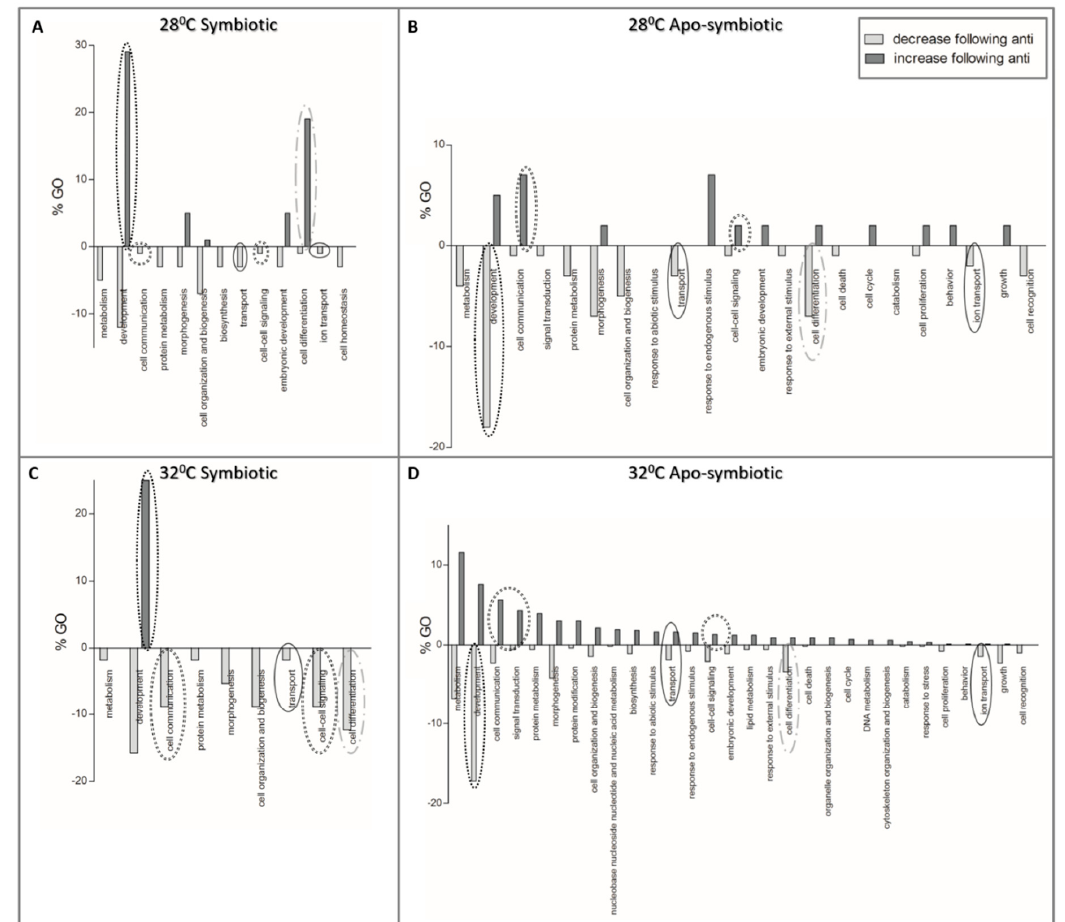
Figure 6. The e ff ect of antibiotic exposure on coral host gene expression. Enriched Gene Ontologies (GOs) of di ff erentially expressed genes which their fold change was either lower (light grey) or higher (dark grey) following the antibiotic exposure. GO slim terms, generated by the web-based tool CateGOrizer [50], are presented as a percentage of the total GOs. ( A ) symbiotic E. paradivisa at 28 ◦ C, ( B ) apo-symbiotic E. paradivisa at 28 ◦ C, ( C ) symbiotic E. paradivisa at 32 ◦ C, and ( D ) apo-symbiotic E. paradivisa at 32 ◦ C. Several GOs of interest are marked with circles: development, communication, differentiation, and transport in the cell.